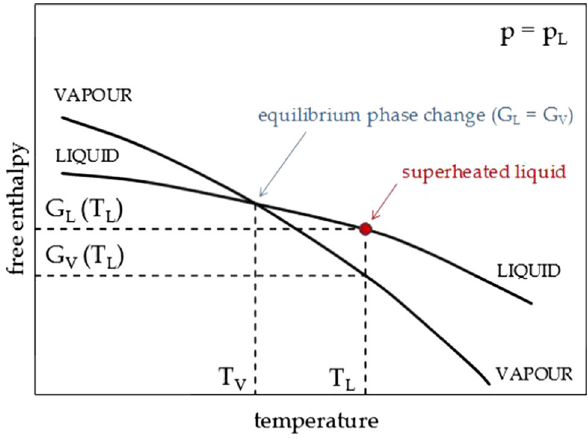
Fig. 2 Distributions of free enthalpies G L and G V vs. T at p = p